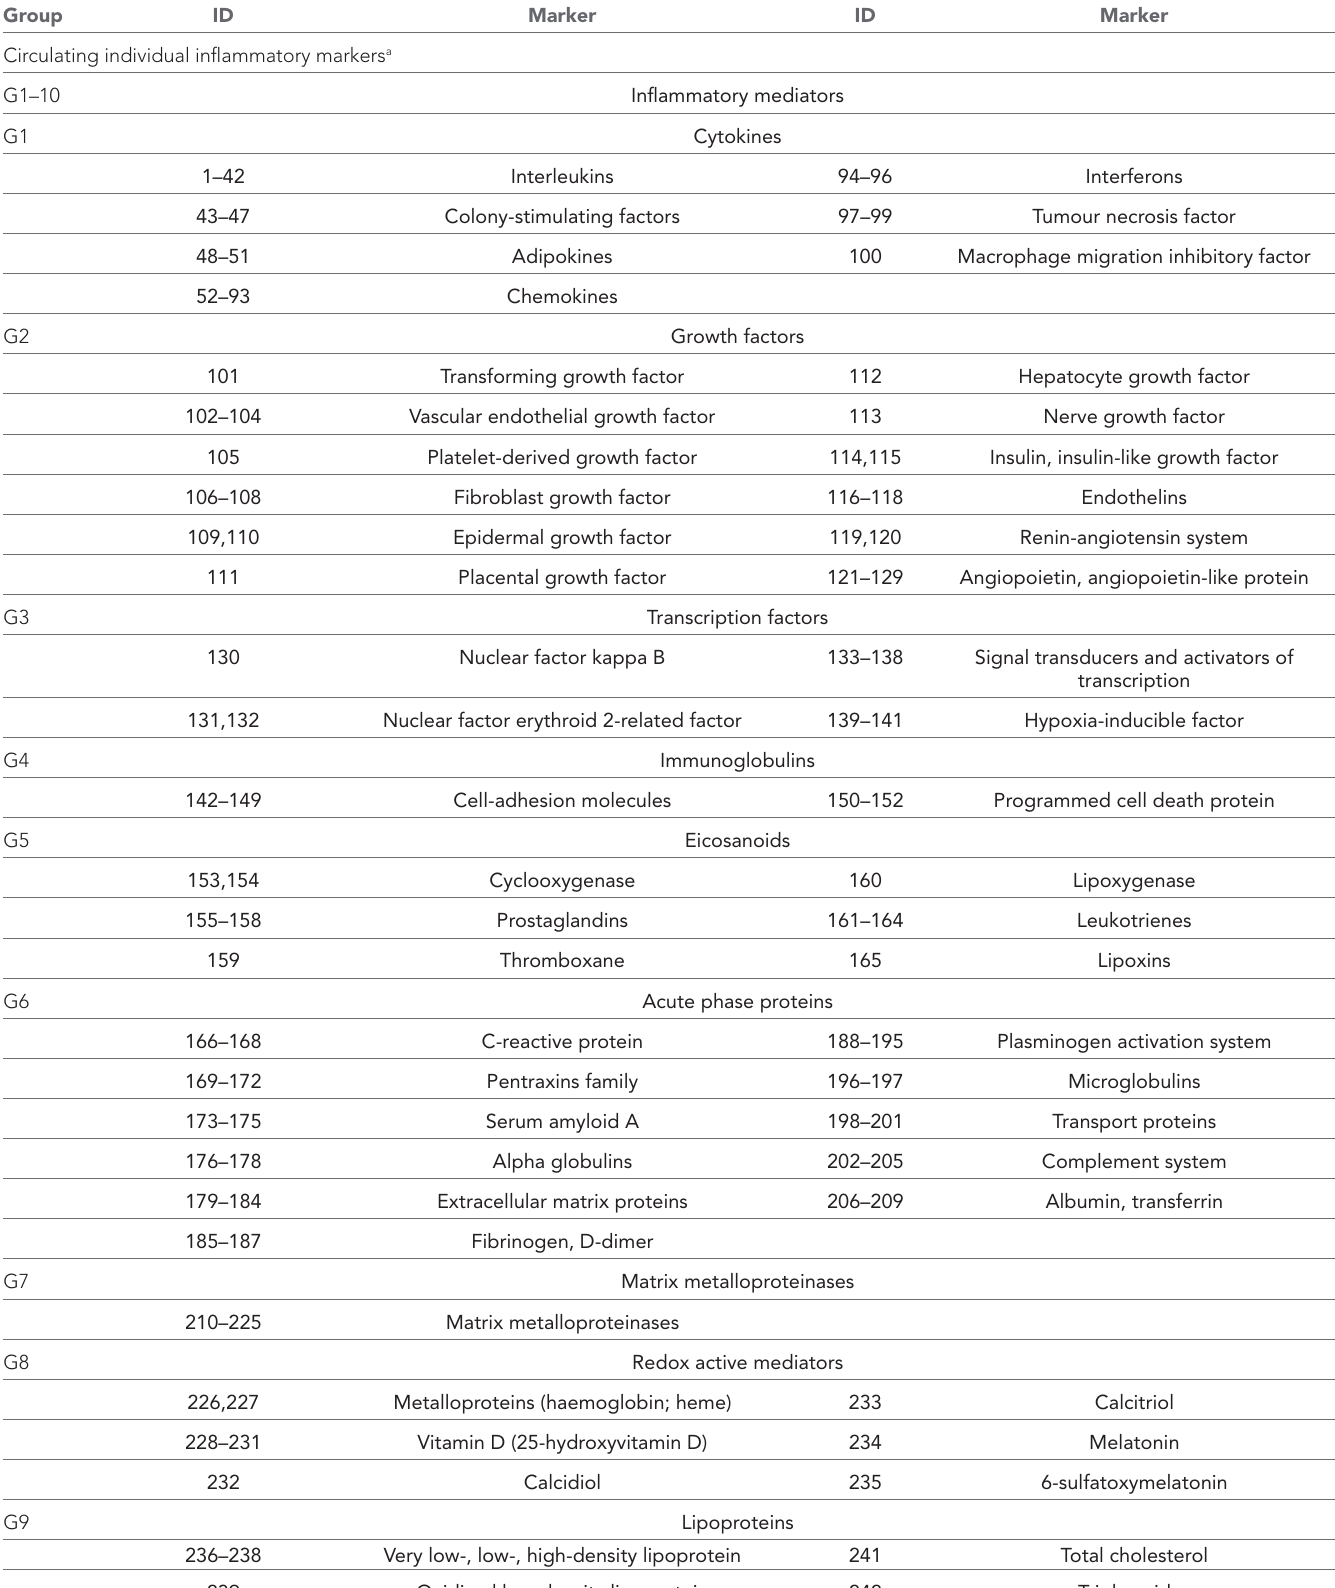
Table 1 Summary of cancer- associated systemic inflammatory response biomarkers